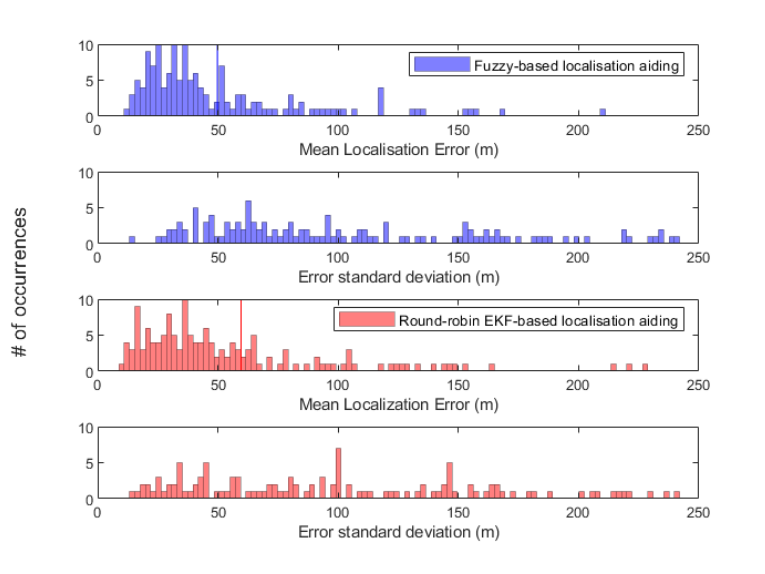
Figure 15. Histogram of the mean localisation error and standard deviation of each AUV of the entire swarm of 150 AUVs. The vertical lines represent the entire swarm mean localisation error, which is 49.76 m and 59.62 m in fuzzy-based and round-robin EKF-based localisation,